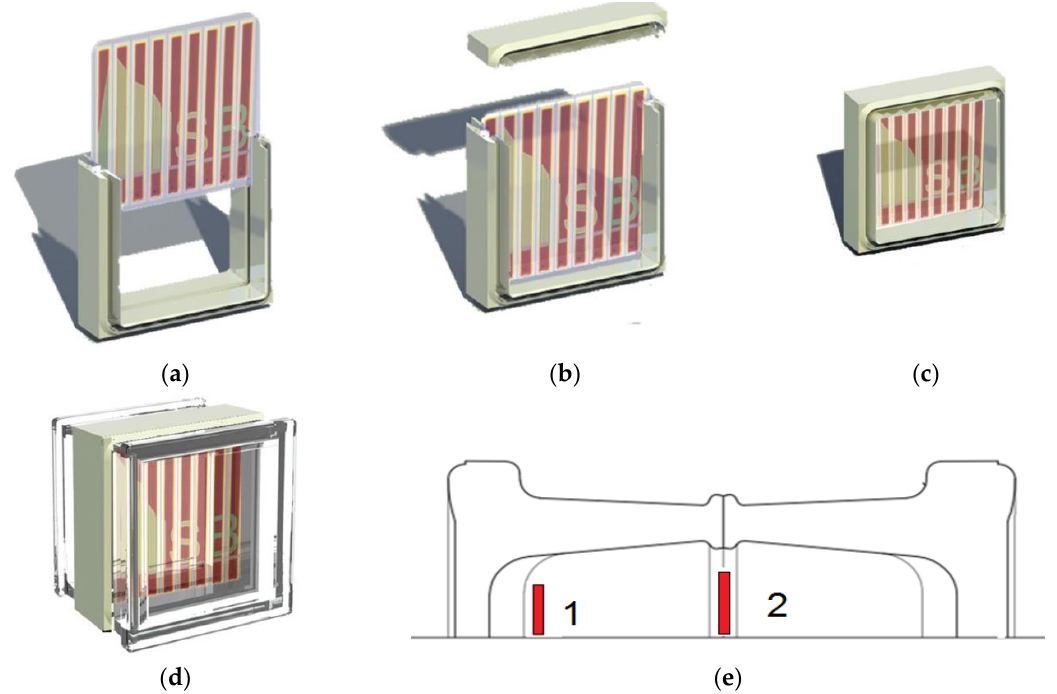
Figure 10. ( a – d ) Structure of the PV DSSC glass block: the opaque edging frame, two glass shell structures and the colored DSSC; ( e ) glass block section where the DSSC is colored in red: 1 internal placement on the surface, 2 in the middle section.